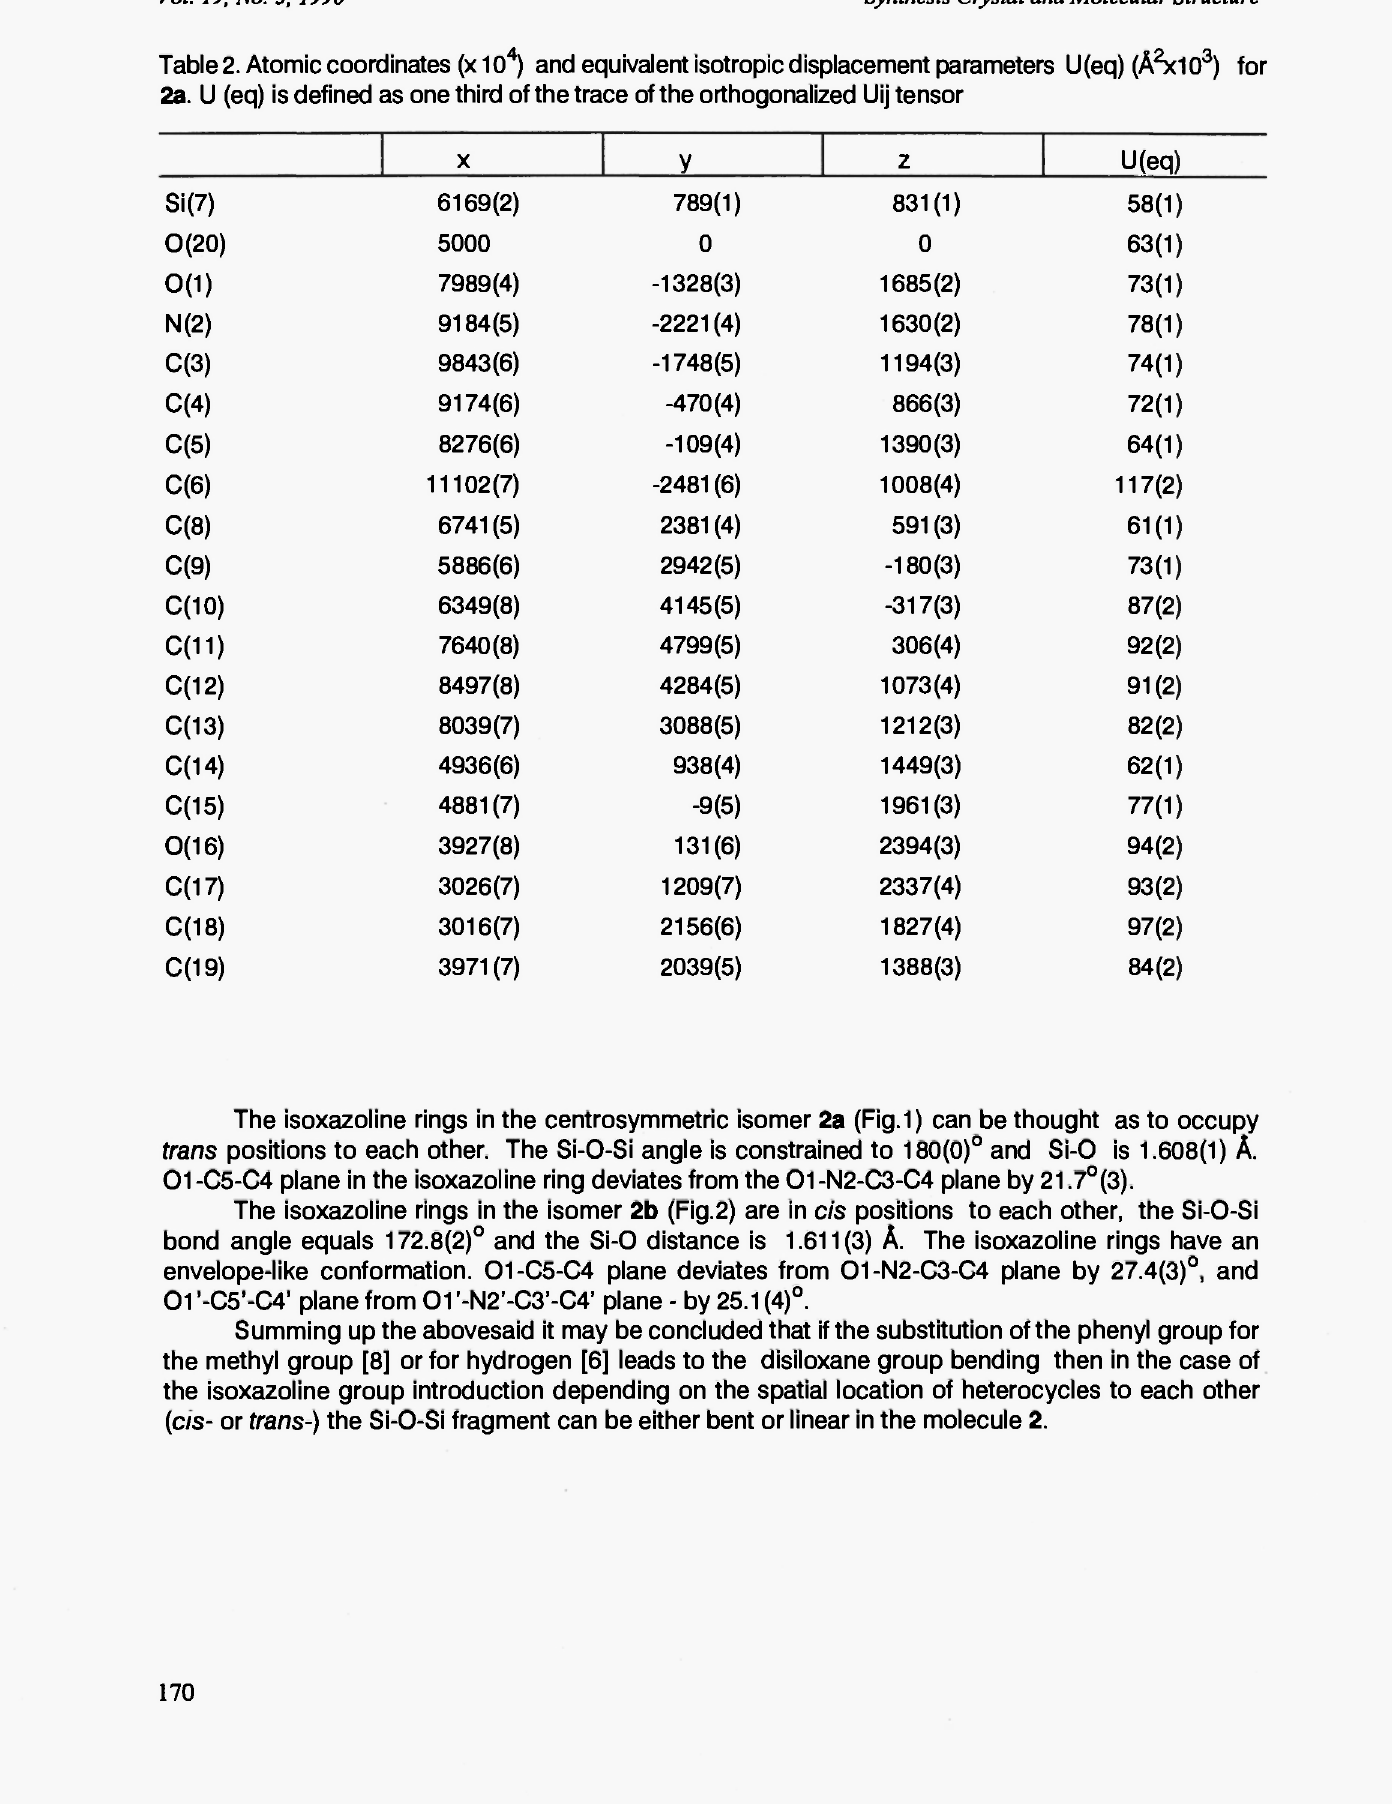
Table 2. Atomic coordinates (χ 10 4 ) and equivalent isotropic displacement parameters U(eq) (ASdO 3 ) for 2a. U (eq) is defined as one third of the trace of the orthogonalized Uij